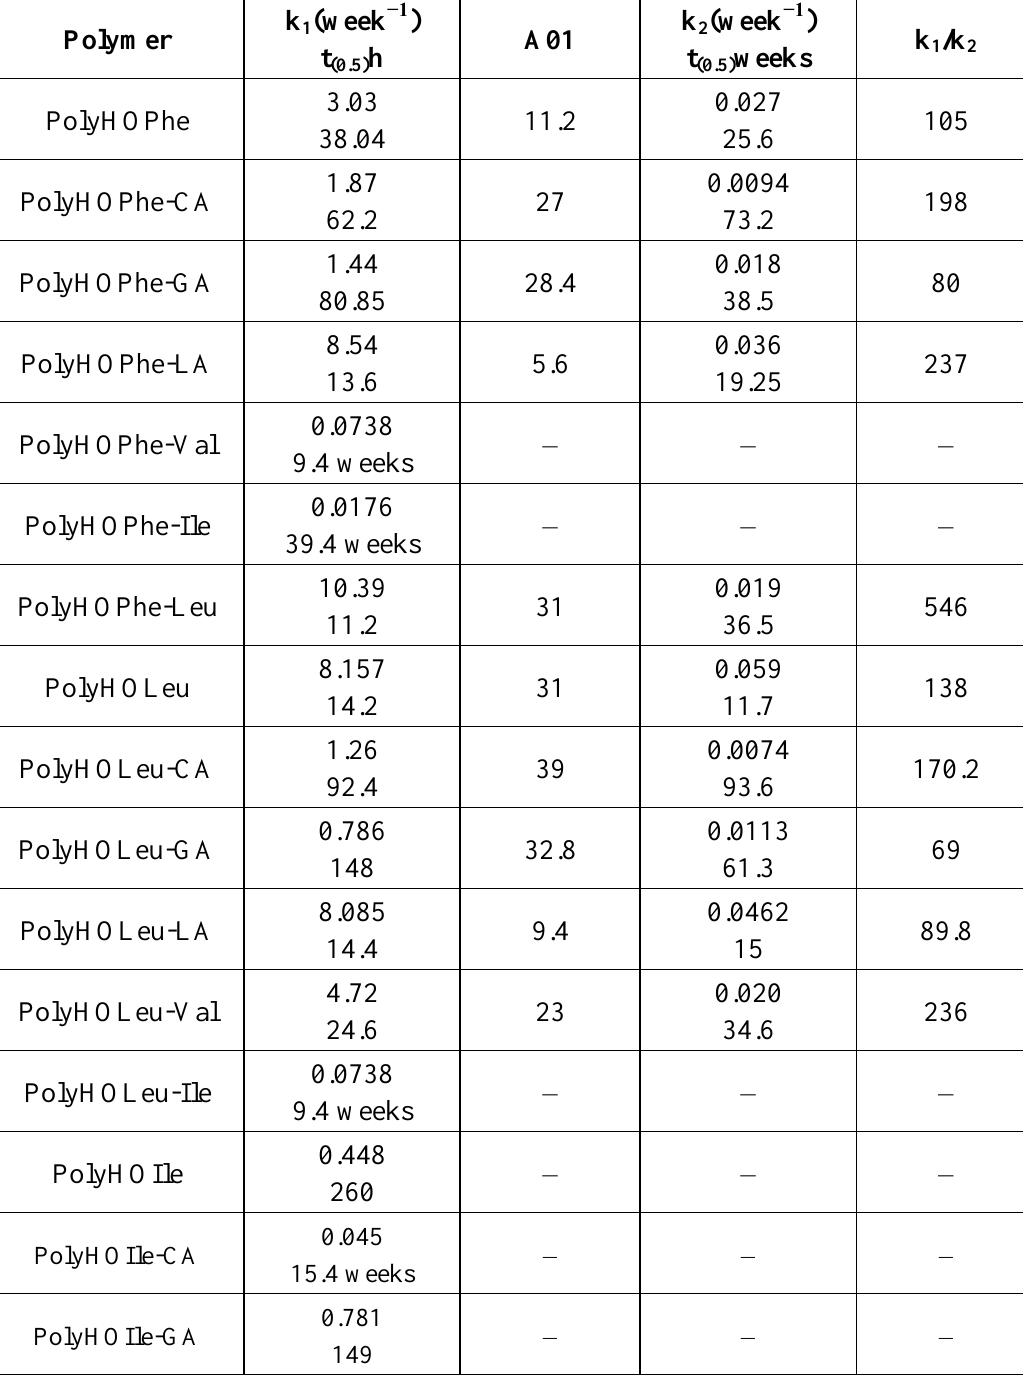
Table 4. Calculated rate constants (k decrease emerging from fitting the experimental data to Equation 2. A01 is the percentage of the molecular weight decrease at the end of the first step of degradation (A01 = (A − A ) ÷ A × 100 T 1 T